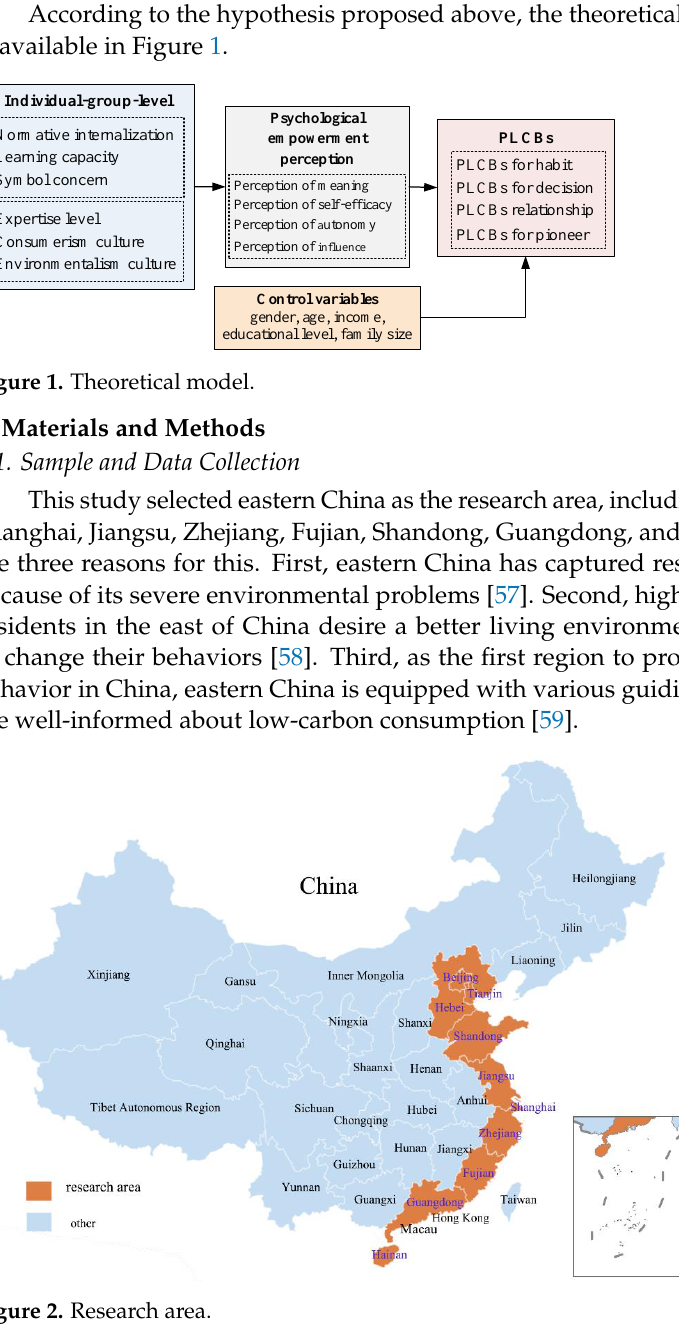
Figure 2. Research